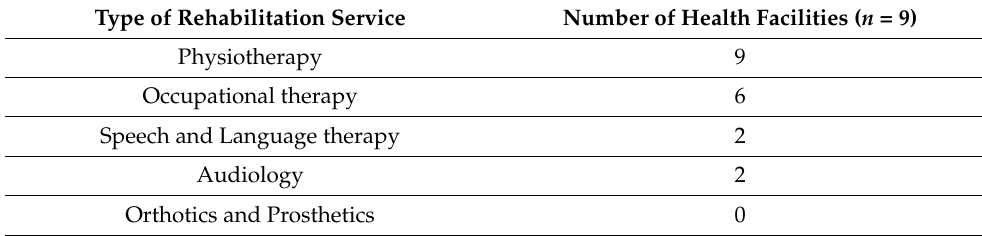
Table 1. Rehabilitation services in OR Tambo district